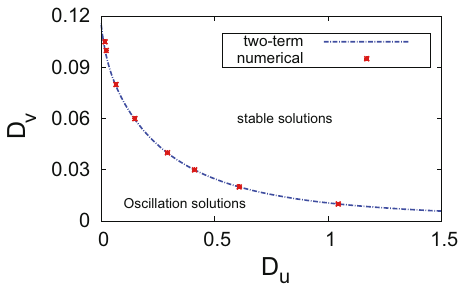
Figure 6: The locus of the degenerate Hopf curve in the D D − u v parameter plane is shown. Other parameters remain as in Figure 4.